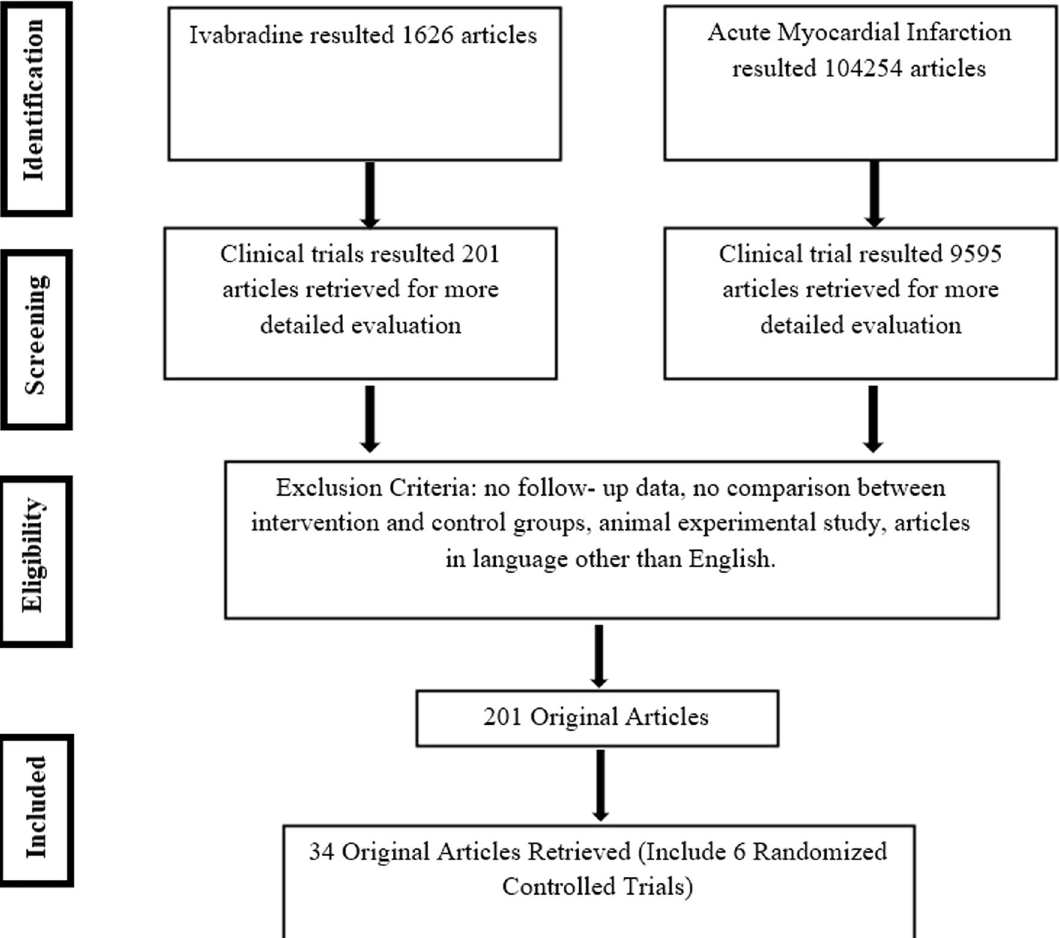
Fig. 1 Flow diagram of data